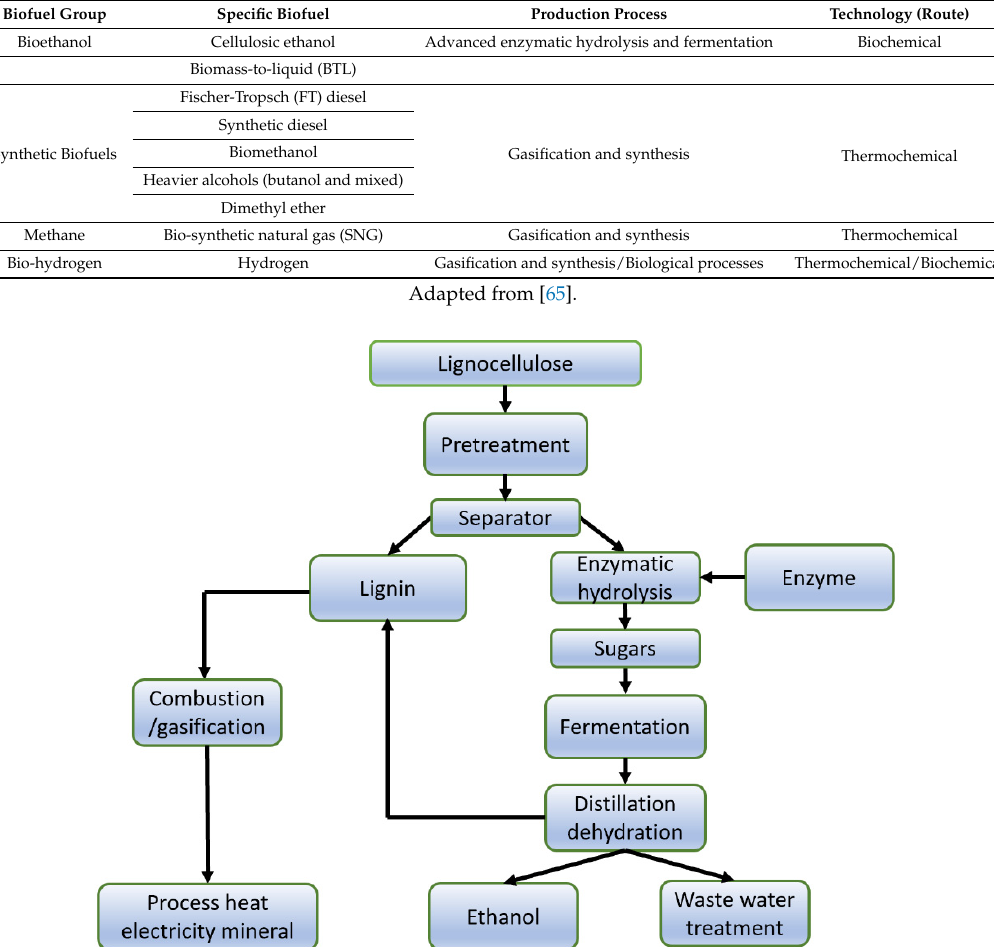
Figure 5. Biochemical process for conversion of lignocellulosic waste to ethanol (adapted from [27]).